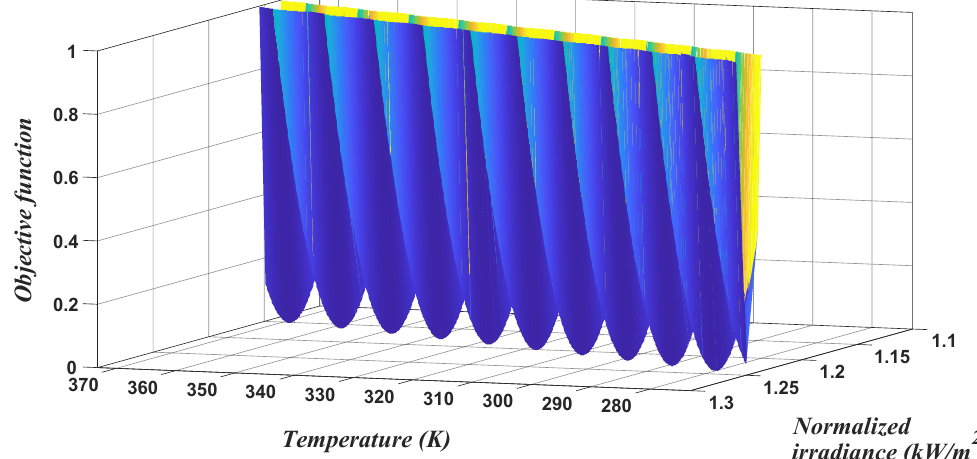
Figure 6. Objective function on the left part of the I - V